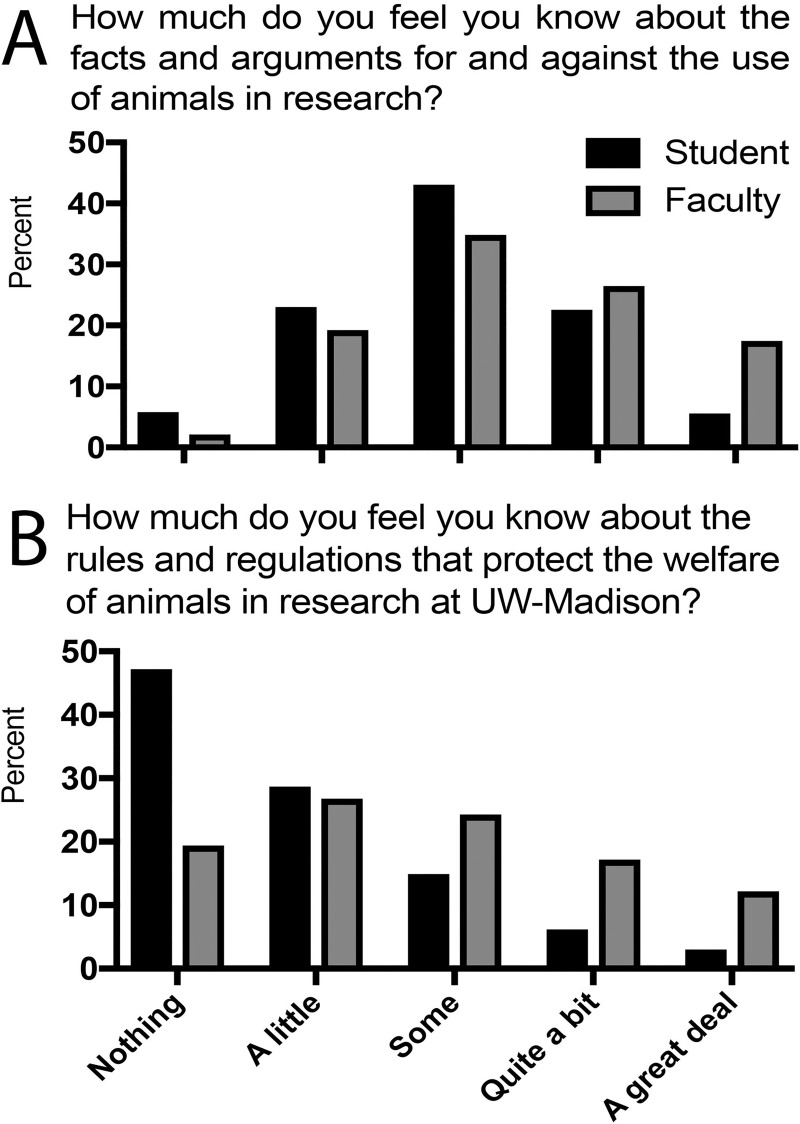
Knowledge about animal research.(A) Knowledge about facts and arguments for and against and about rules and regulations governing animal research. (B) Knowledge about rules and regulations that protect the welfare of animals in research.